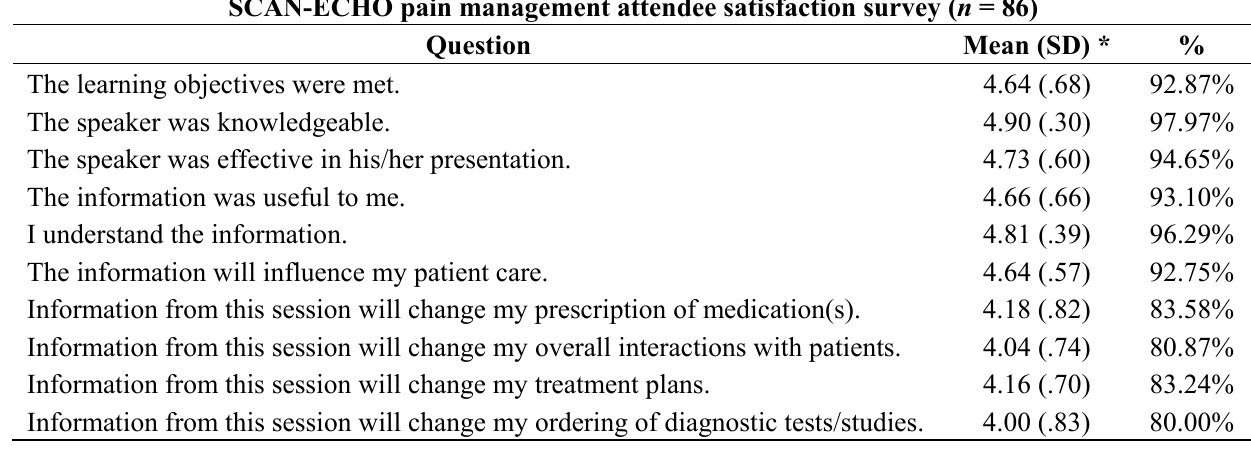
Table 2. Responses to SCAN-ECHO pain management post-meeting Attendee Satisfaction Survey (sent to all attendees).